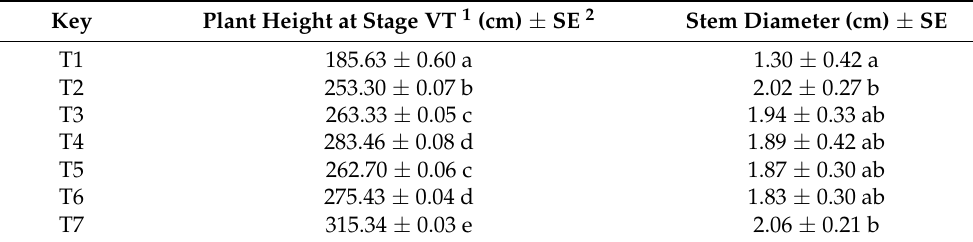
Table 2. Data obtained for the growth variables evaluated in the different fertilization schemes